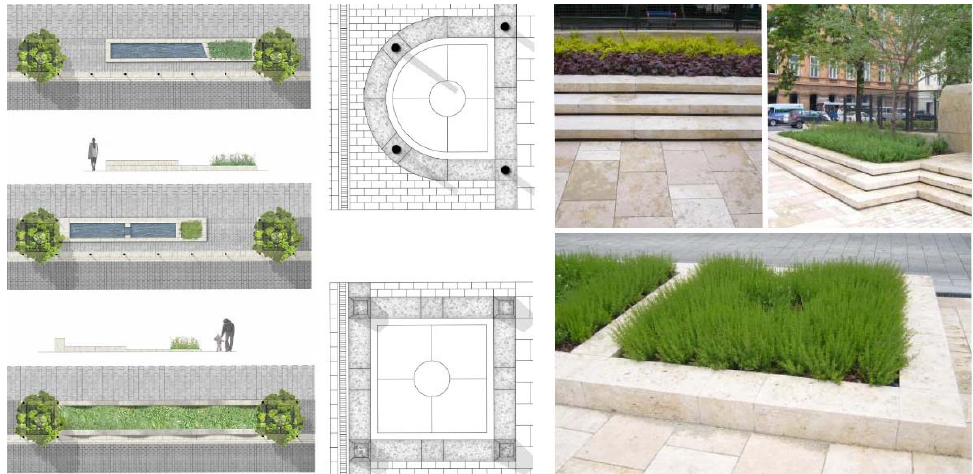
Figure 3. The limited space available and the narrow streets required several elaborate design details for the location of water features and plants. (Photos by the authors, 2012).